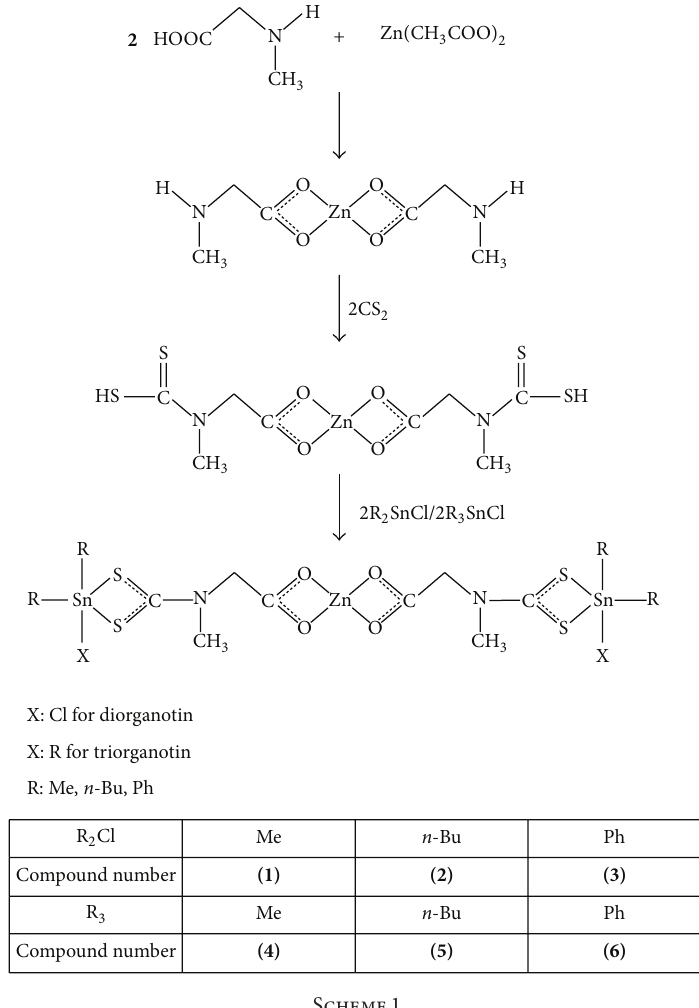
Table 1: Physical data of heterobimetallic complexes with sarcosine.